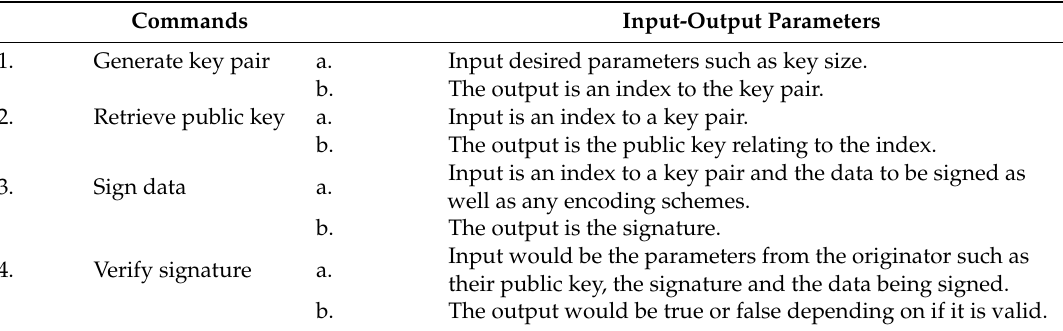
Table 9. API commands to support the generation of asymmetric signature algorithms.